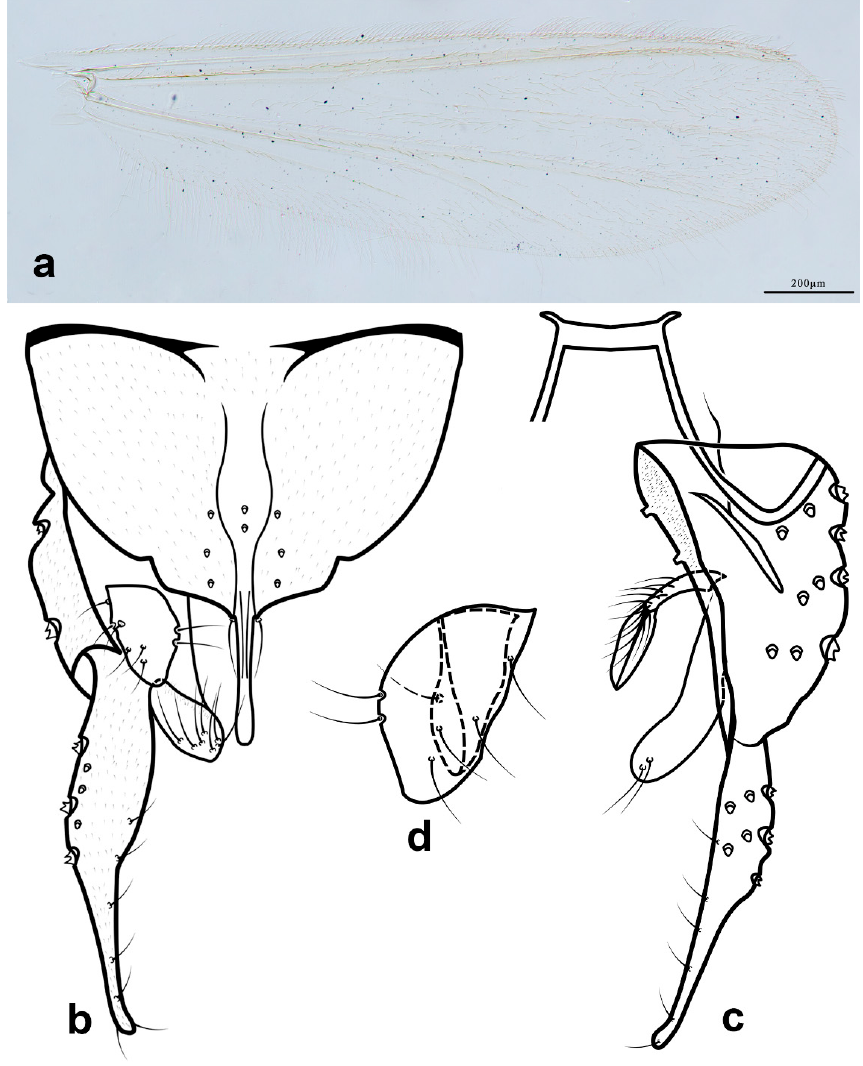
Figure 6. Rheotanytarsus illiesi: ( a ) wing; ( b ) hypopygium, dorsal view; ( c ) hypopygium, ventral view; ( d ) superior volsella.